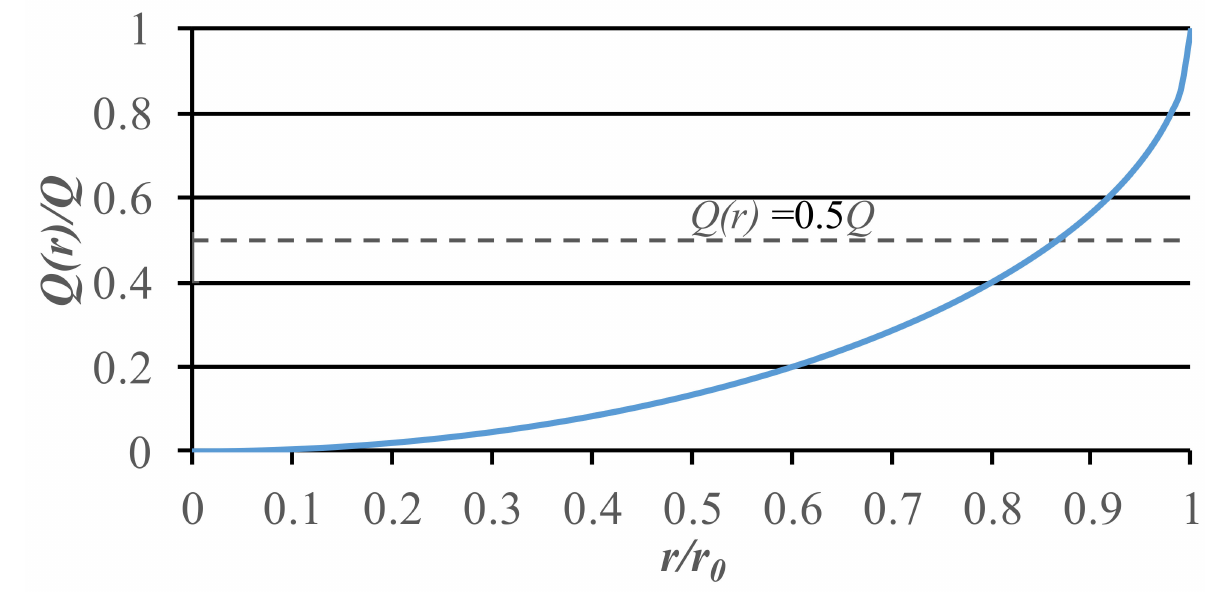
Figure 8. Cumulative flow curve through the exit.